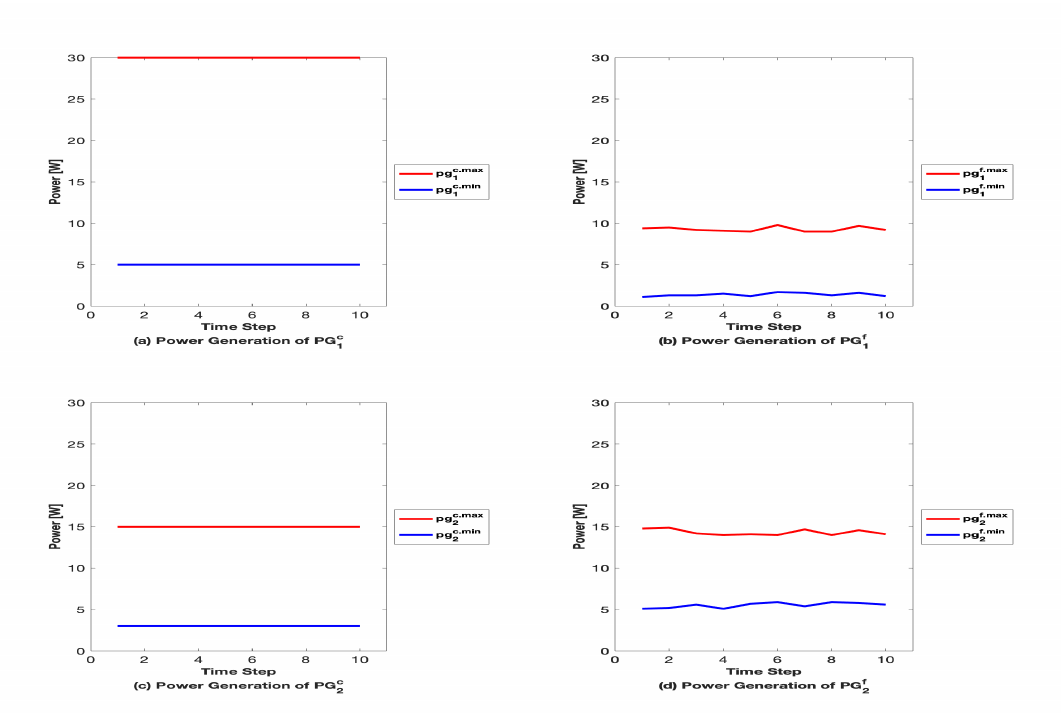
Figure 12. Time dependent power generation limitations of 4 power generators.